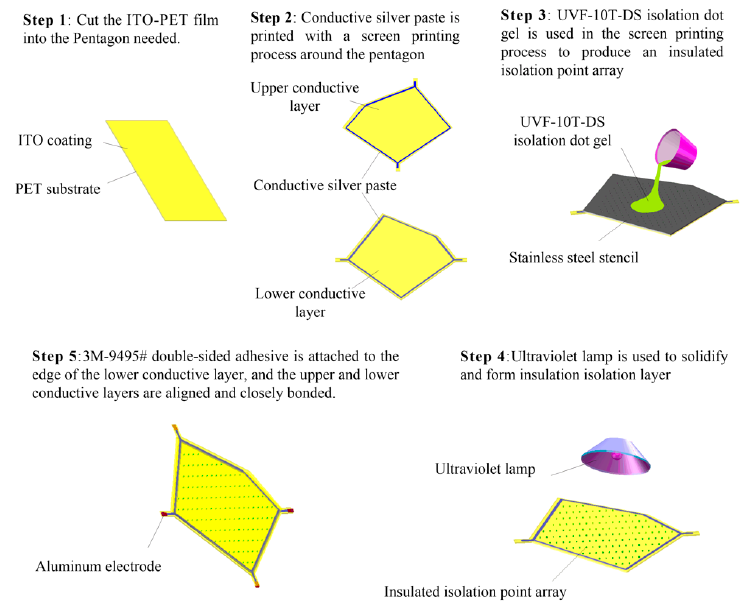
Figure 13. Process of fabricating the sensor.